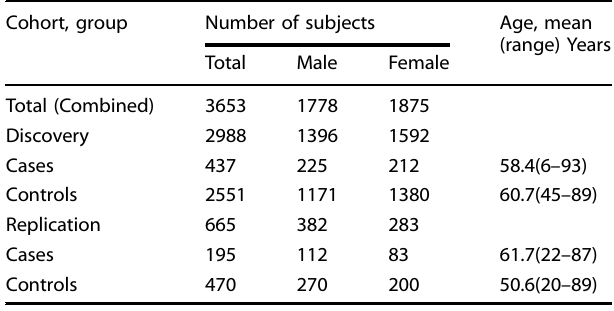
Table 1. Characteristics of the genotyped samples used for